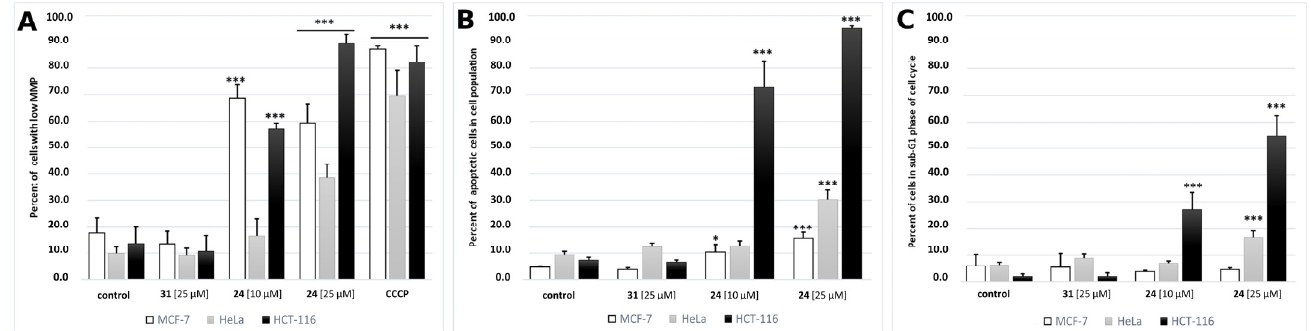
Figure 6. Cytometric analysis of MCF-7, HeLa, and HCT-116 cells treated with 24 (10 µ M or 25 µ M) or 31 (25 µ M) for 72 h. ( A ) Mitochondrial membrane potential. MMP analysis was performed using 25 μ M JC-1 staining for 30 min before the end of 72 h treatment period. As a low MMP control CCCP-treated cells (100 μ M) for 15 min were used. Results represent the mean number of cells with low MMP (low JC-1 fluorescence) ± SD (n = 9) (*** p < 0.001). ( B ) Cytometric analysis of phosphatidylserine translocation to the outer leaflet of cell membrane. Results represent the mean number of cells with translocated phosphatidylserine ± SD (n = 9) (* p < 0.05; *** p < 0.001). Number of necrotic cells in that analysis was negligible. ( C ) Cytometric analysis of sub-G1 phase of cell cycle. Results represent the mean number of cells with translocated phosphatidylserine ± SD (n = 12) (*** p <